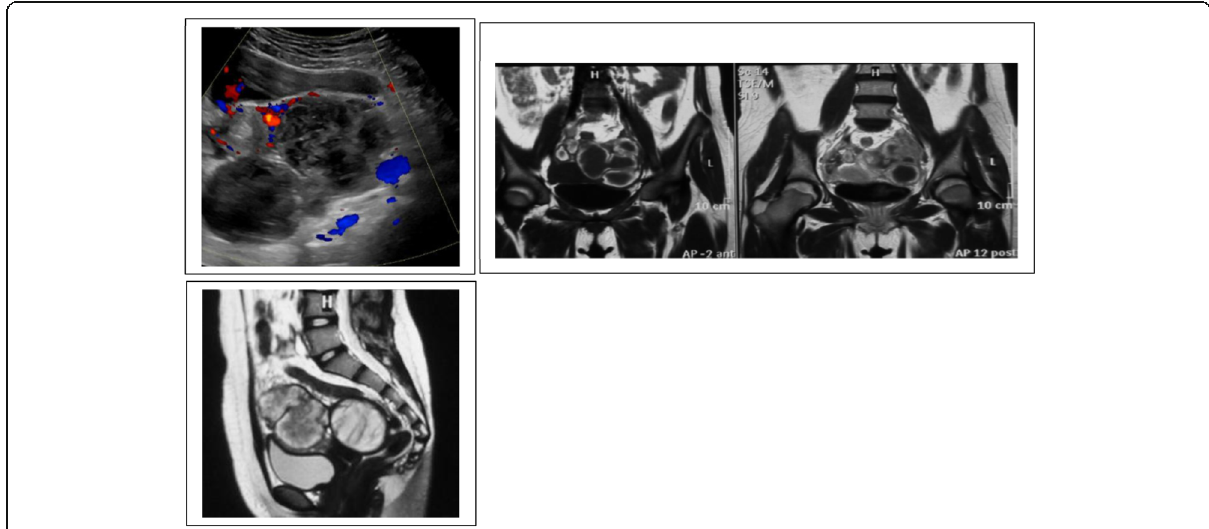
Fig. 7 Haemorrhagic tubo-ovarian complex lesion. Female patient 17 years old presented by menorrhagia. a US image revealed left complex adnexal mass with thick septa, only peripheral vascularity was seen. b – d MRI T1 pre- and postcontrast, T2 revealed haemorrhagic tubo-ovarian complex. On clinical and laboratory assessment, bleeding tendency was detected with final diagnosis of idiopathic thrombocystopenic